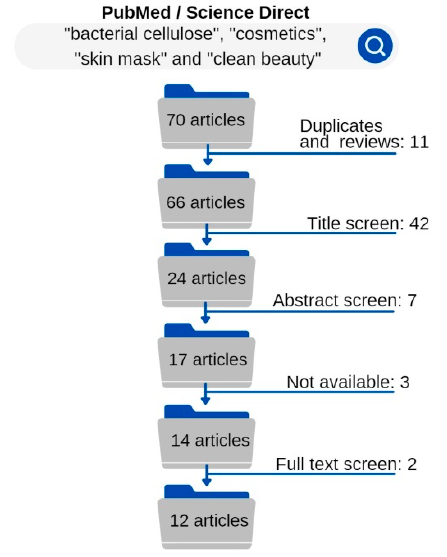
Figure 1. Graphical representation of the perspective of publications on the use of bacterial cellulose in cosmetics in the last decade.